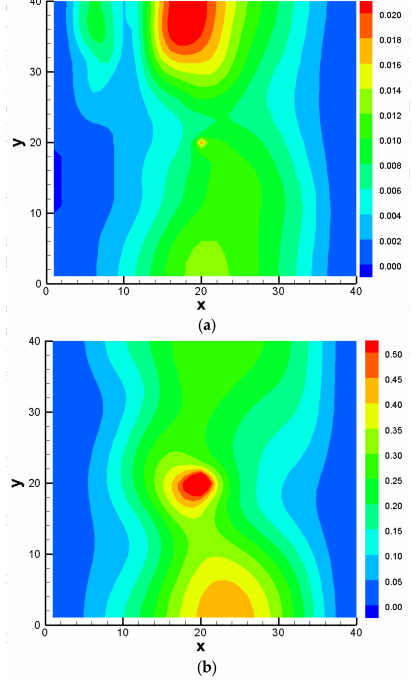
Figure 12. Comparison of model averaged total variance based on: ( a ) MC method; ( b ) PCM